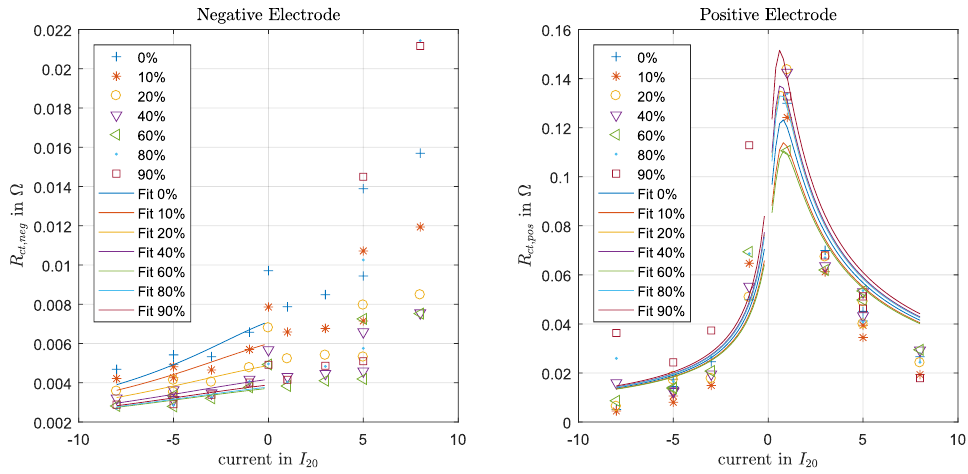
Figure A2. Determined charge-transfer resistances from fitting of impedance spectra for negative electrode and from pulses for positive electrode, together with the fitting curves of Butler-Volmer equation.